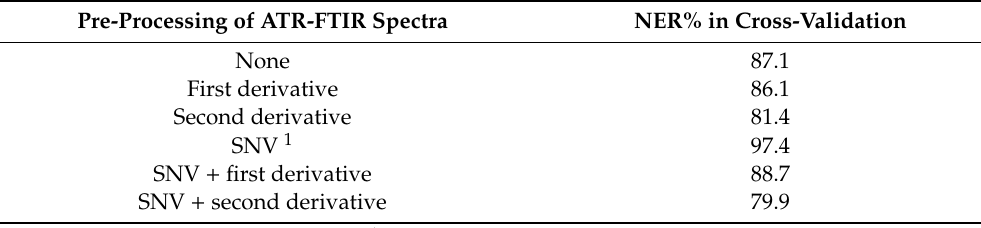
Table 2. Proportion of correctly classified potato samples (non-error-rate, NER%) in leave-one-out cross-validation for di ff erent pre-processing methods of the ATR-FTIR spectra.